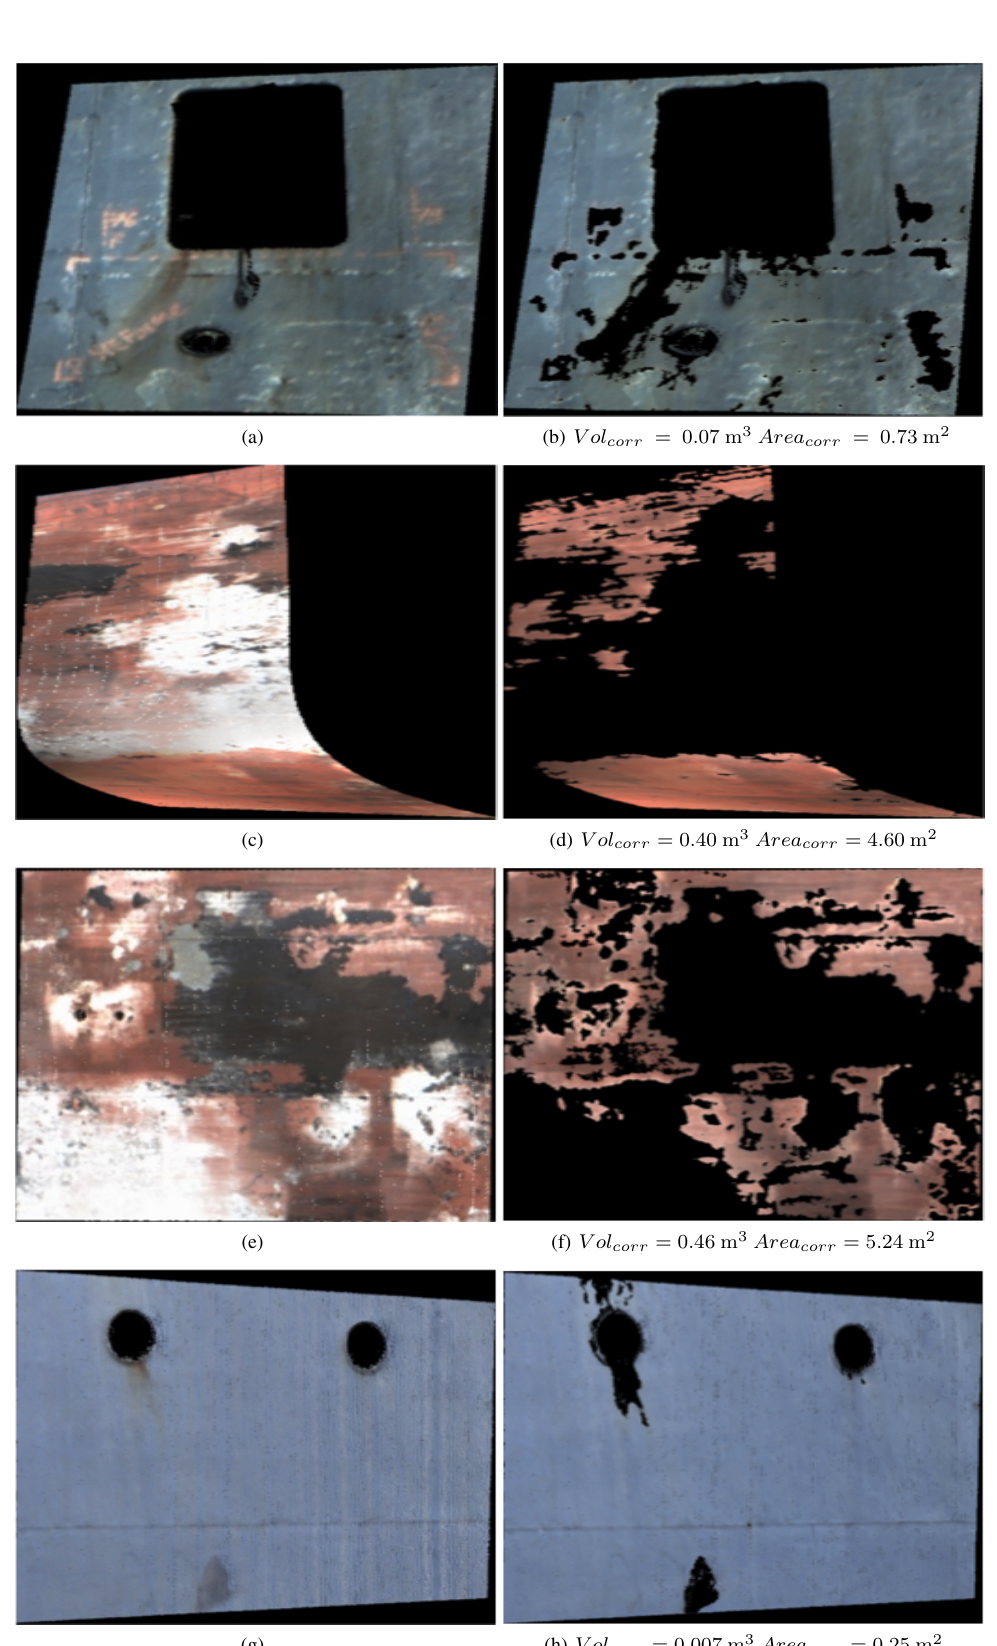
Figure 6. (a), (c), (e) & (g) show the colored 3D point clouds of different zones while (b), (d), (f) & (h) present the 3D point clouds with the corroded region segmented out along with the corresponding V ol corr and Area corr